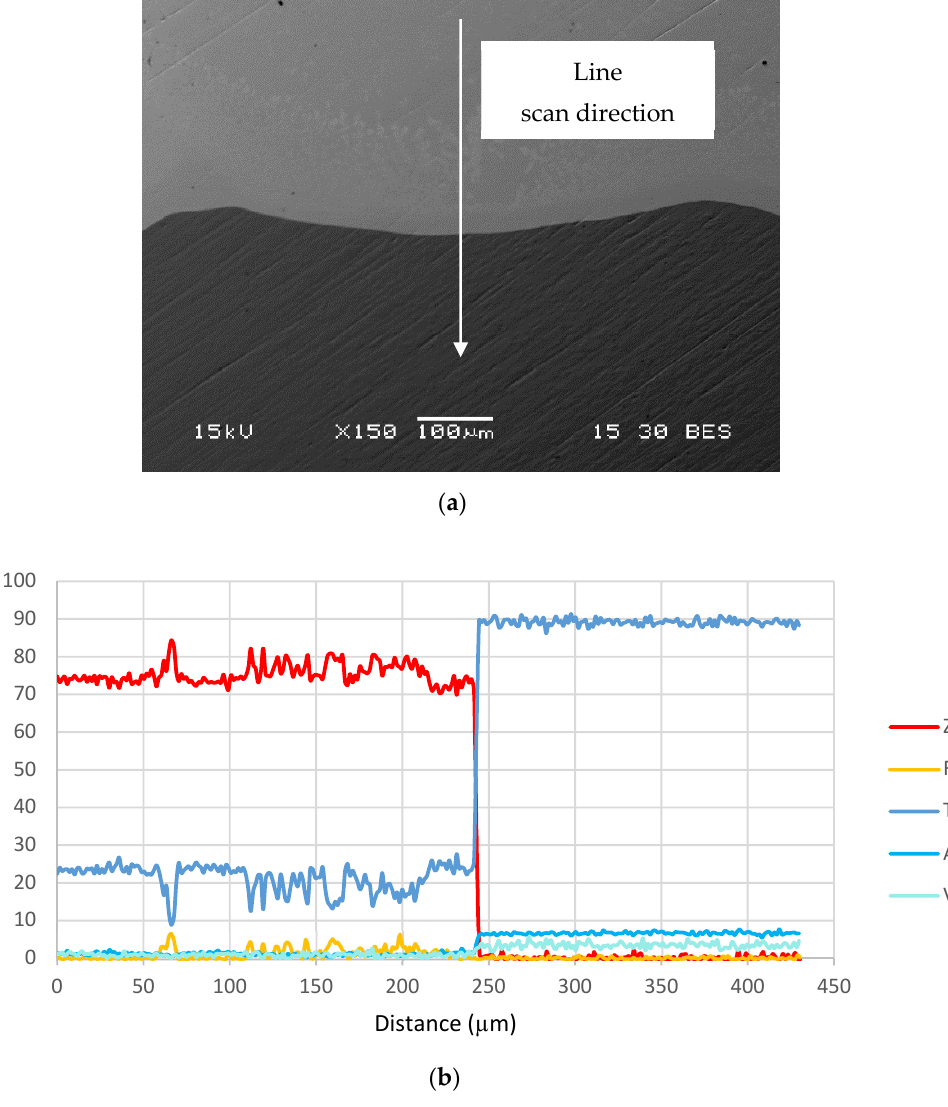
Figure 3. Chemical composition of the interface layer between the Ti-base lattice and infiltrated Zn–2%Fe alloy—( a ) line scan direction and ( b ) chemical composition obtained by EDS analysis.